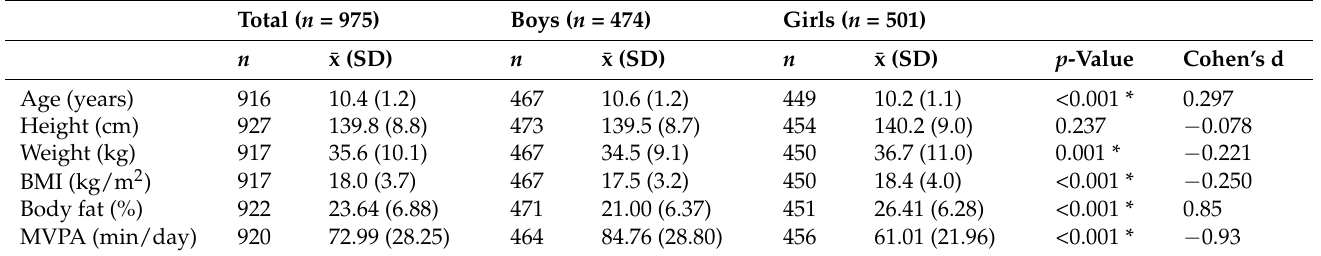
Table 1. Descriptive statistics were presented for the whole group and by sex